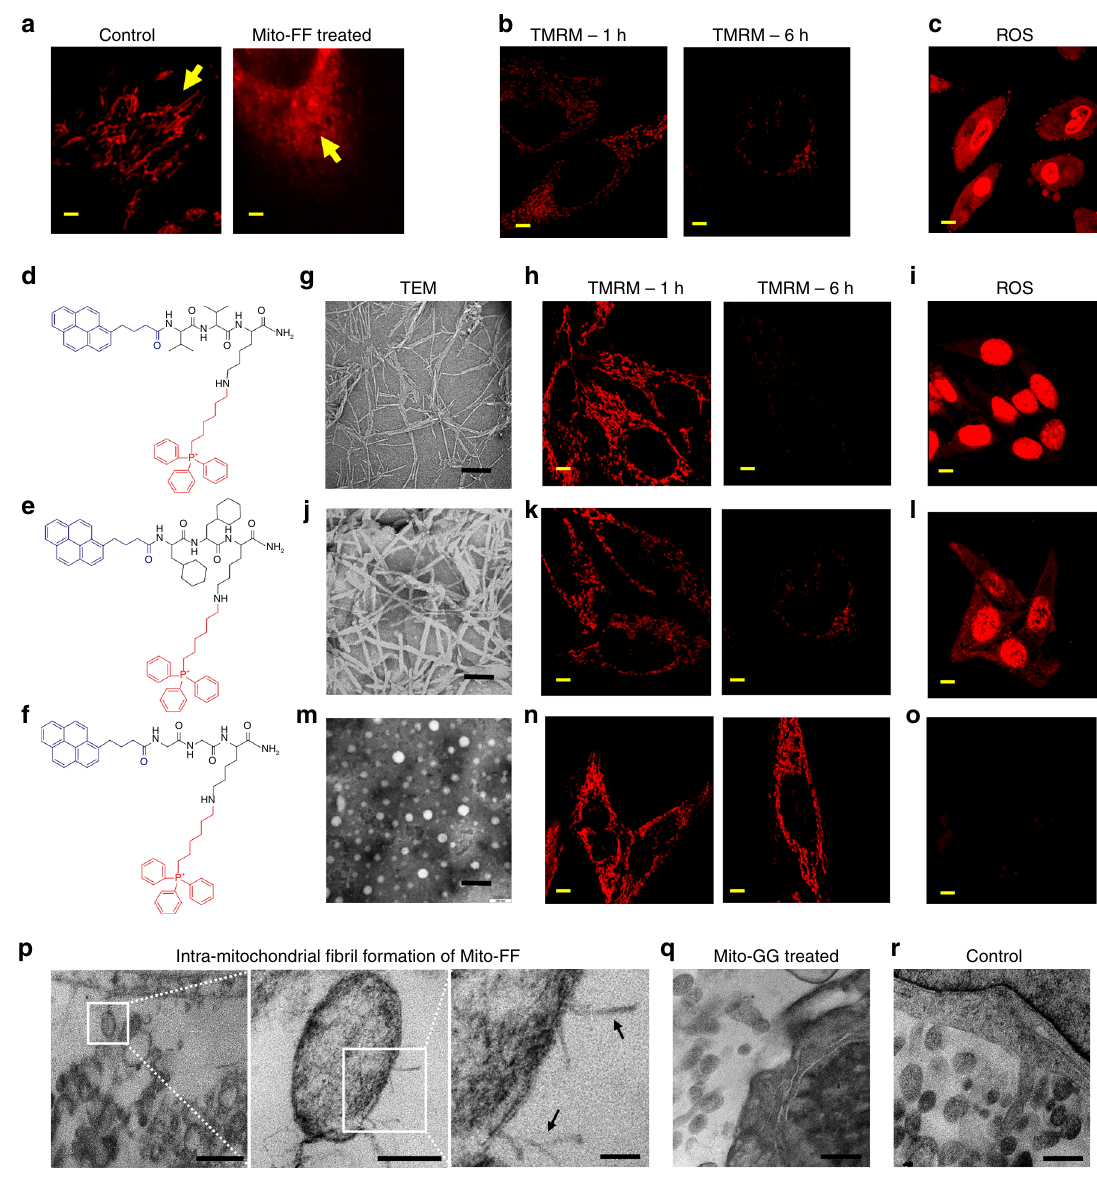
Fig. 4 Mitochondrial dysfunction. a Confocal analysis showing mitochondrial shrinkage after Mito-FF treatment on HeLa cells ( right ), compared with control ( left ) (scale bar, 1 μ m). b Membrane depolarization of mitochondria over time after treatment with Mito-FF was measured by TMRM (scale bar, 2 μ m). c ROS generation measured by DHE (scale bar, 5 μ m). d – f Molecular design of the control peptides. g TEM image of Mito-VV (scale bar, 500 nm). h Membrane depolarization induced by Mito-VV after 1 or 6 h (scale bar, 2 μ m), and i intracellular ROS generation (scale bar, 5 μ m). j From left : TEM image of Mito-F x F x (scale bar, 200 nm). k Membrane depolarization induced by Mito-F x F x after 1 or 6 h (scale bar, 2 μ m) and l intracellular ROS generation (scale bar, 5 μ m). m From left : TEM image of Mito-GG (scale bar, 200 nm). n Membrane depolarization induced by Mito-VV after 1 or 6 h (scale bar, 5 μ m), and o intracellular ROS generation. p TEM images of mitochondria within the HeLa cell showing the morphological damage induced by Mito-FF. Fibers formed inside the mitochondria and extruded out of the membrane (scale bar, from left to right ; 1 μ m, 200 nm, and 50 nm). q Mito-GG-treated mitochondria HeLa cell showing no damage of mitochondria. r Control HeLa cell mitochondria (scale bar, 500 Supplementary Fig. 21) and hydrophobicity of Mito-FF fi brils favors strong interactions with the mitochondrial membrane, which could destroy the negatively charged mitochondrial membrane 22, 23 . To determine whether the fi brous assembly could induce membrane disruption, we conducted a dye-leakage assay using a model liposome encapsulated with a self-quenching dye (calcein). The addition of Mito-FF fi brils (500 μ M) rapidly caused a loss of membrane integrity in the liposomes, as indicated by the leakage of the encapsulated calcein dye (Fig. 5a). Dye leakage increased over time and reached a maximum leakage of 50% within 45 min. However, the addition of Mito-FF in the